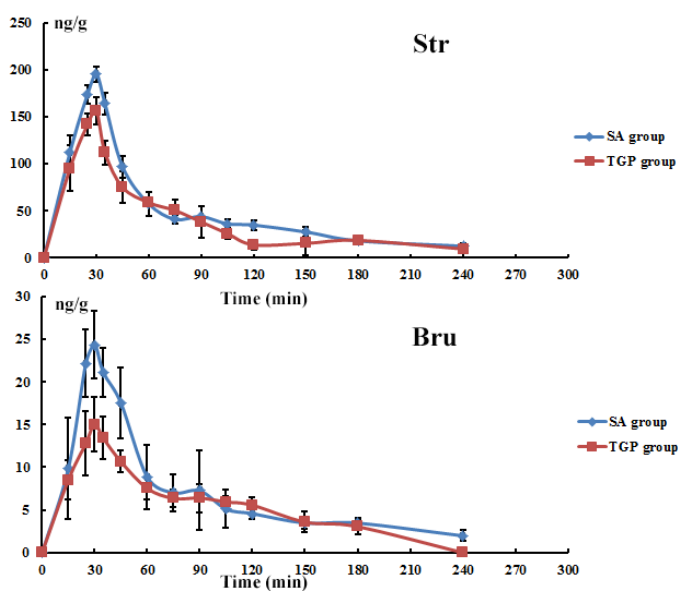
Figure 8. Tissue time course of Str and Bru in the SA group and TGP group in brain. There were at least three rats per time point in each group. Each point represents mean ± SD.